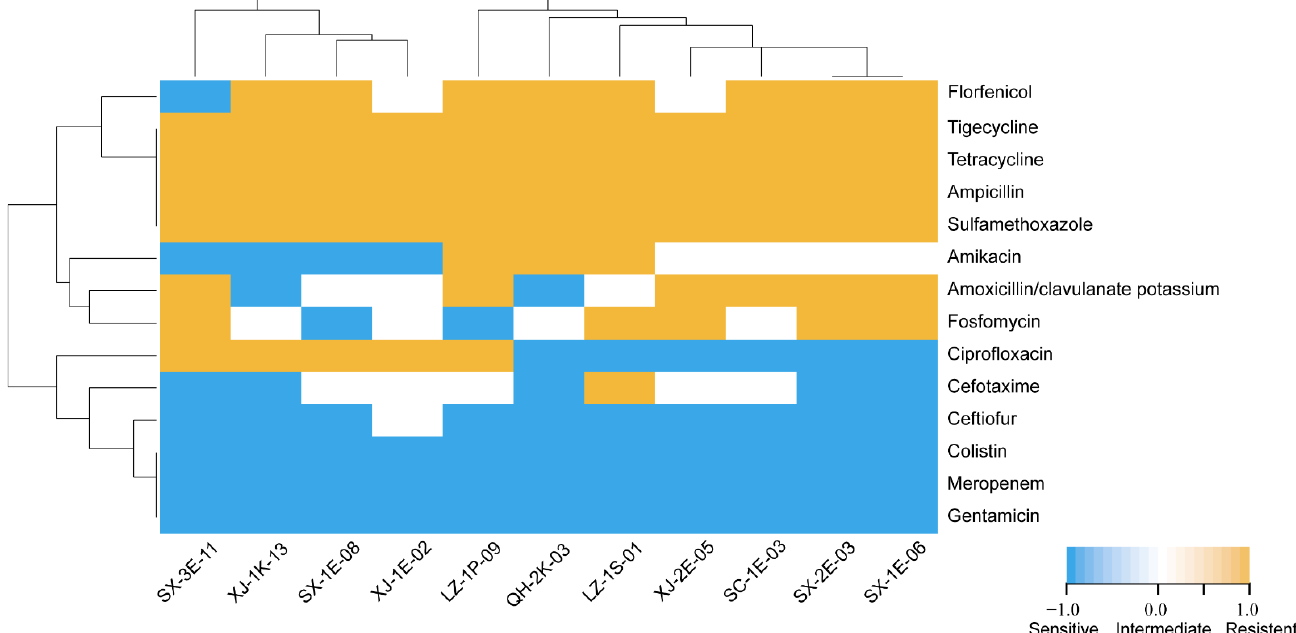
Figure 2. Cluster analysis of tigecycline-resistant characteristics of isolates. Vertical and horizontal trees represent clustering relationships. The ordinate is the antibiotic, and the abscissa is a tigecy-